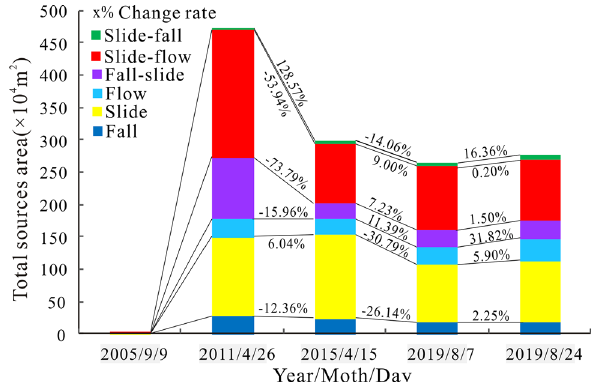
Figure 11. Change of source materials with different movement types based on multiple phases of remote sensing images.